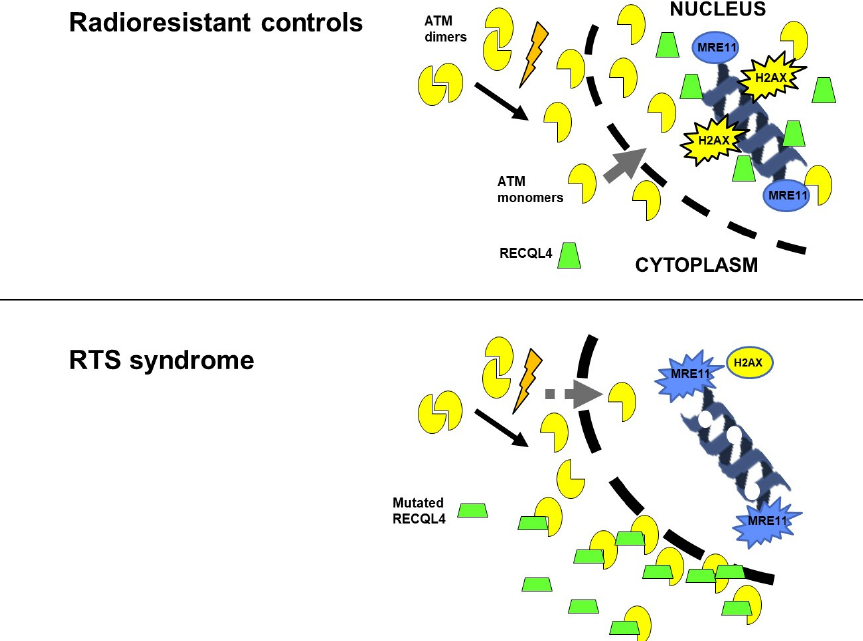
Figure 10. The RTS and the RIANS model. Schematic illustration of the RIANS model for the radioresistant and the RTS cells. The IR-induced ATM monomers diffuse in the nucleus, in which they trigger the DSB repair pathway by phosphorylating H2AX (activation of NHEJ) and MRE11 (inhibition of the nuclease activity). In the RTS cells, RECQL4 mutations lead to impaired cytoplasmic localization and/or overexpression of the RECQL4 protein, which results in more ATM-RECQL4 complexes: a significant delay of RIANS occurs with a lack of DSB recognition and repair and increased MRE11 activity. This delay of RIANS may be alleviated by ZOPRA treatment.